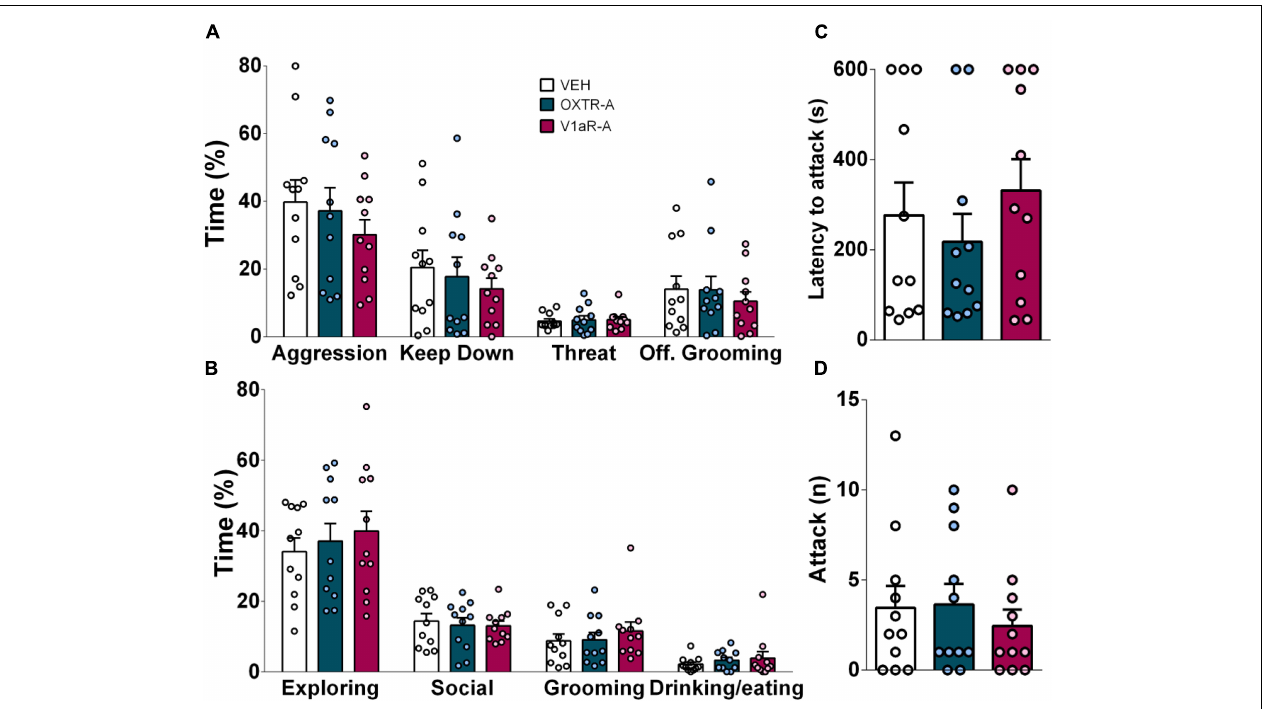
FIGURE 4 | Infusion of either OXT receptor antagonist (OXTR-A, dark blue bars) or V1a receptor antagonist (V1aR-A, dark pink, both at 100 ng/0.5 µ l per side) into the CeA did not affect (A) aggressive behavior, neutral or social behaviors (B) , or (C) attack latency, (D) the number of attacks displayed by virgin female IST rats. Data presented as mean +